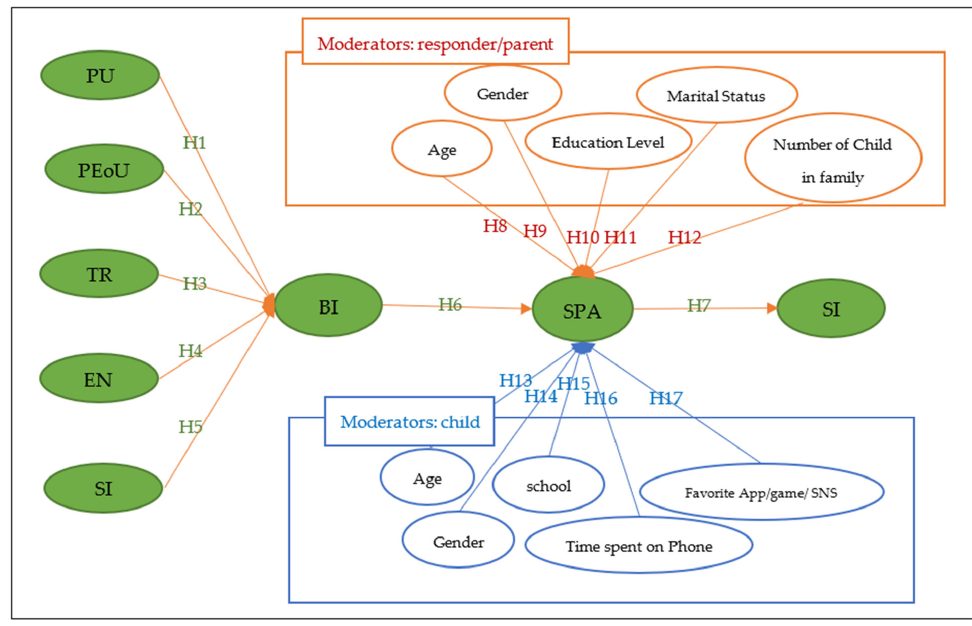
Figure 1. Proposed Model.